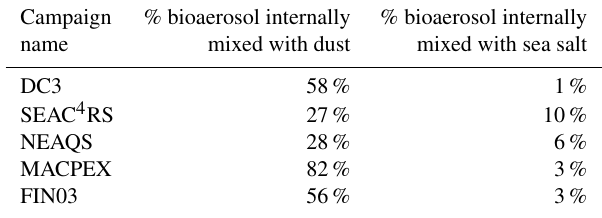
Table 1. Internal mixing of bioaerosol particles described in this study. Bioaerosol markers as defined in Zawadowicz et al. (2017) can be co-located with silicate markers (Fig. 2) or sea salt markers (Cl − and other NaCl-derived clusters) in the same particle, indicat- ing internal